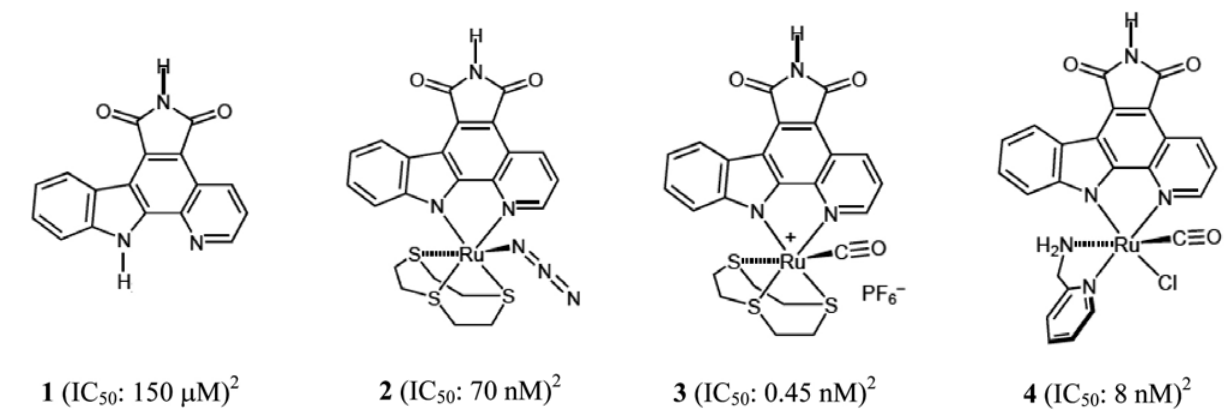
Figure 1 . Molecular structure of the ruthenium-staurosporine compounds 2